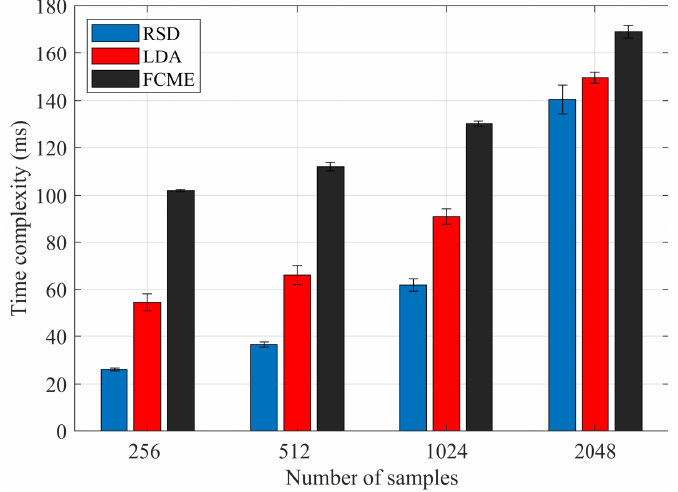
Figure 6. Time complexity as an average execution time of the detection process for a given number of